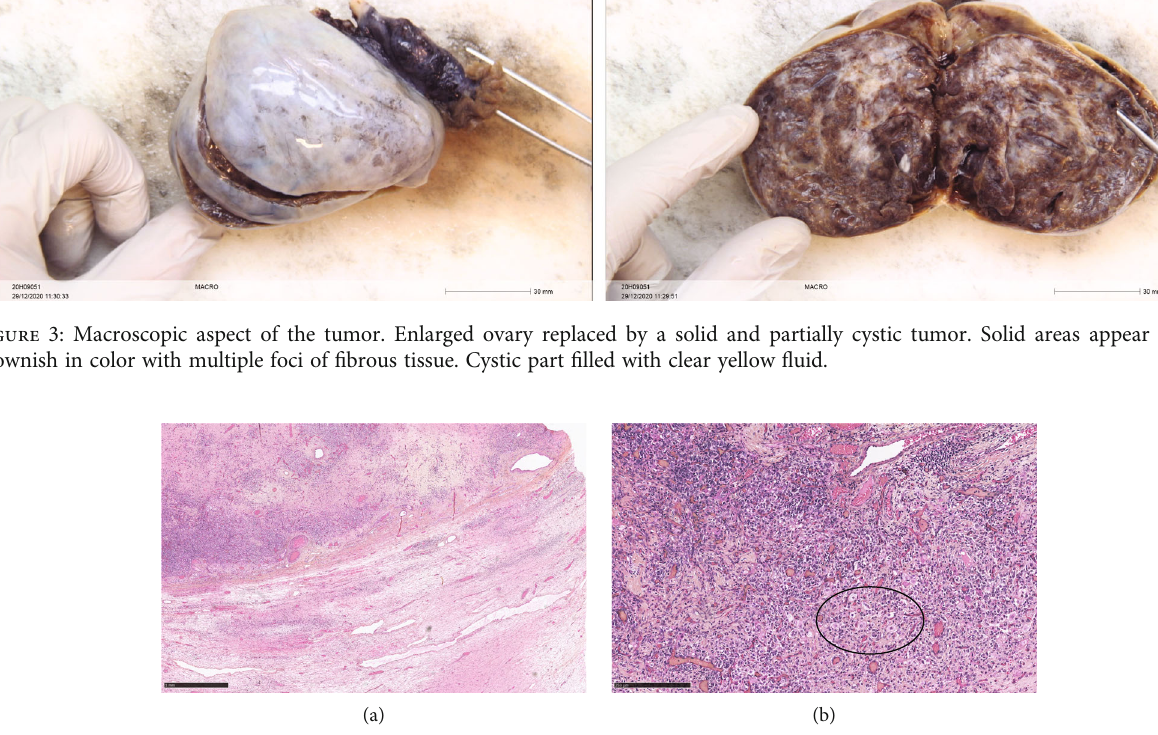
Figure 4: H&E staining at low power view. Cellular lobules are separated by zones of loose fi brous and fi bromyxoid mesenchymal stroma